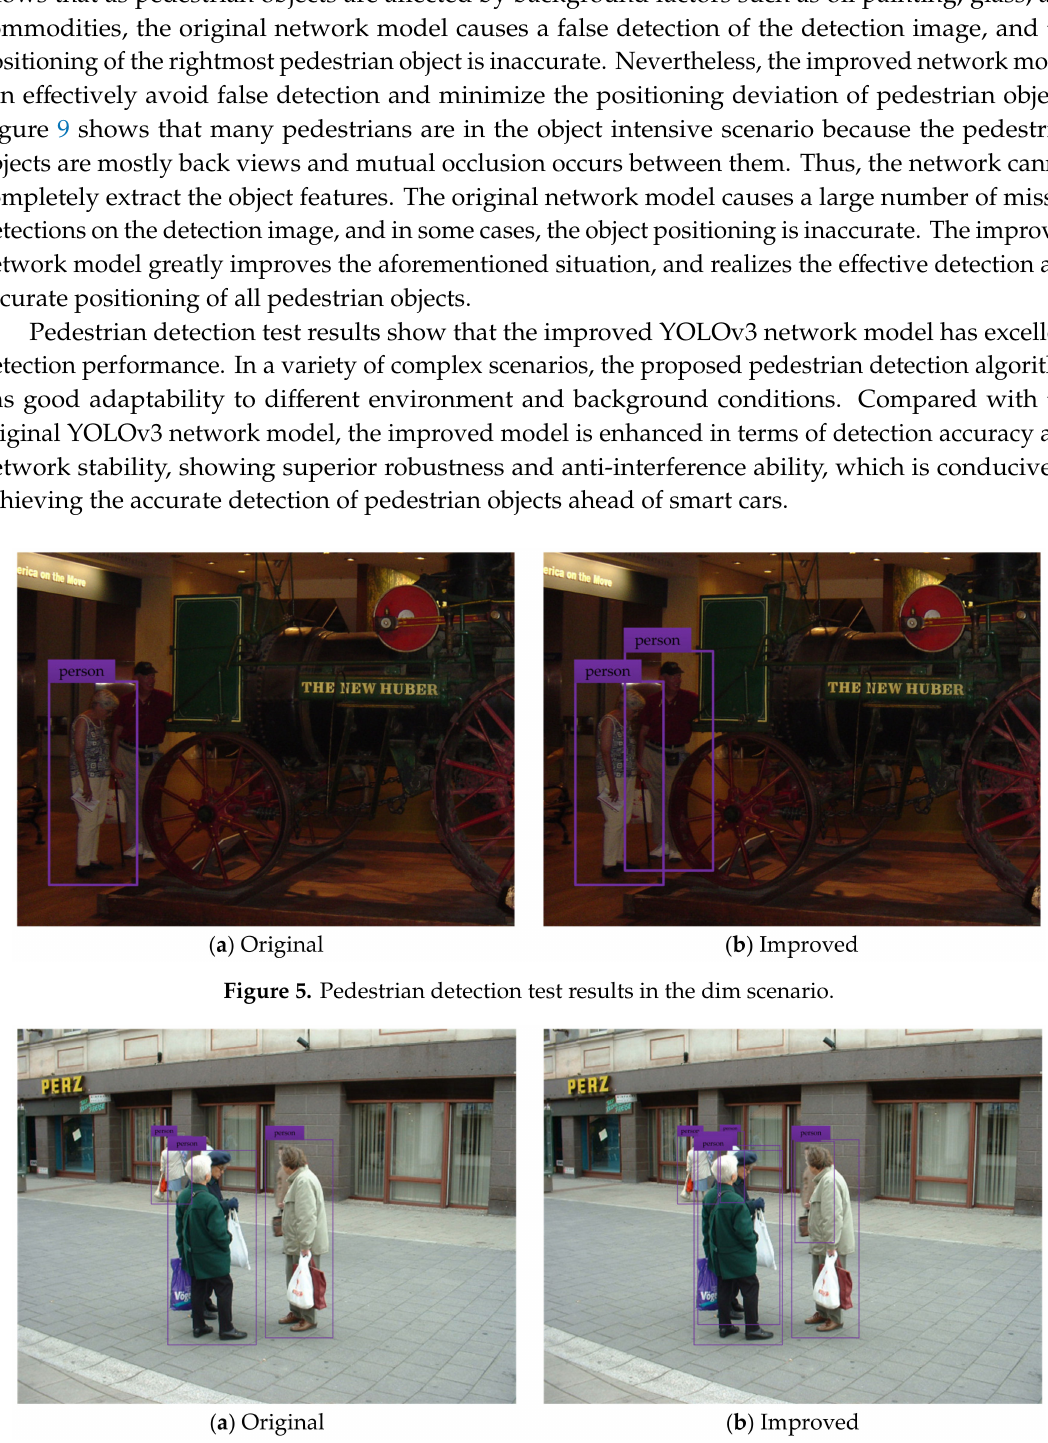
Figure 6. Pedestrian detection test results under